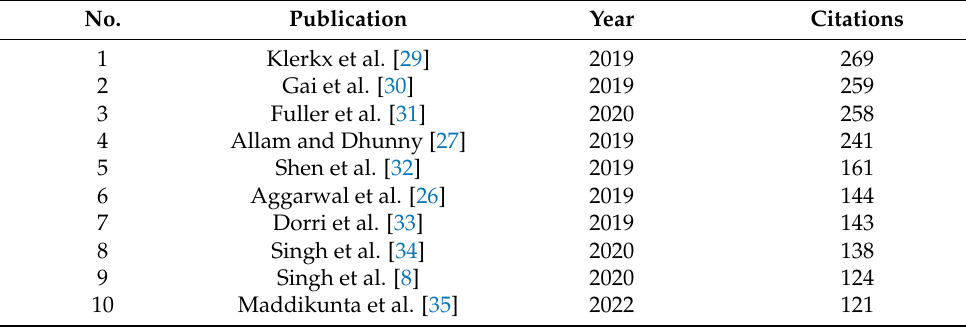
Table 3. The most globally cited publications in the subject field.